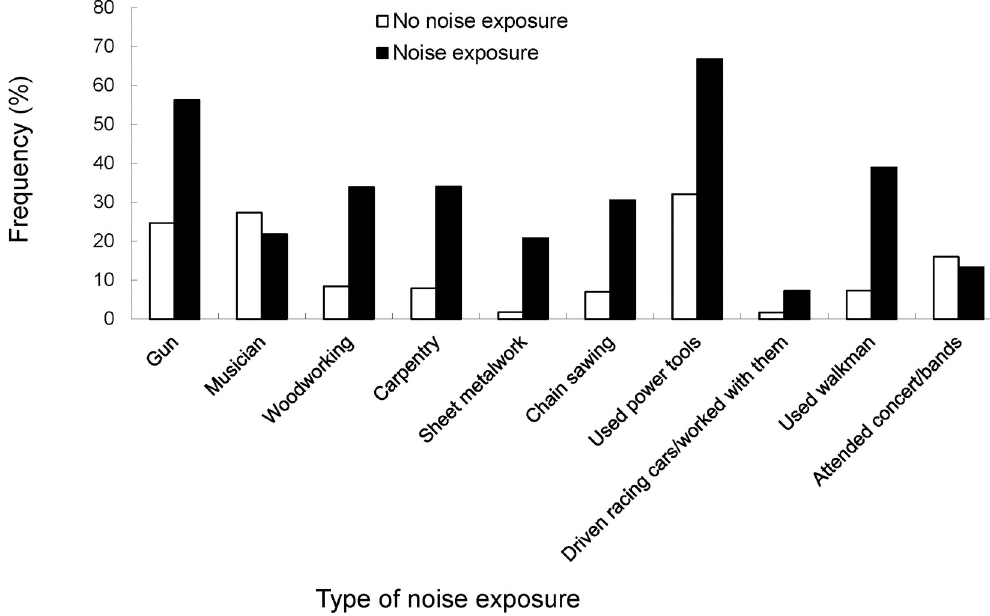
Fig 1. Type of occupational or recreational noise exposure reported by participants of the Blue Mountains Hearing Study at baseline (1997–9).